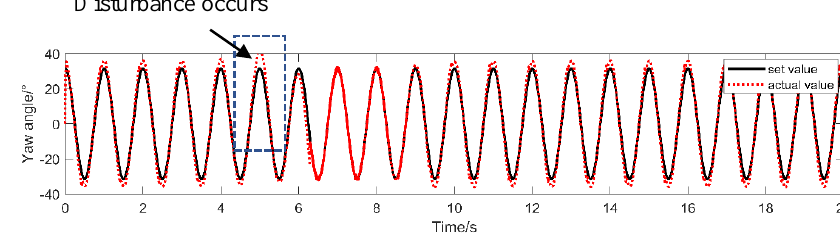
Figure 13. Y a w tracking of SMF controller.